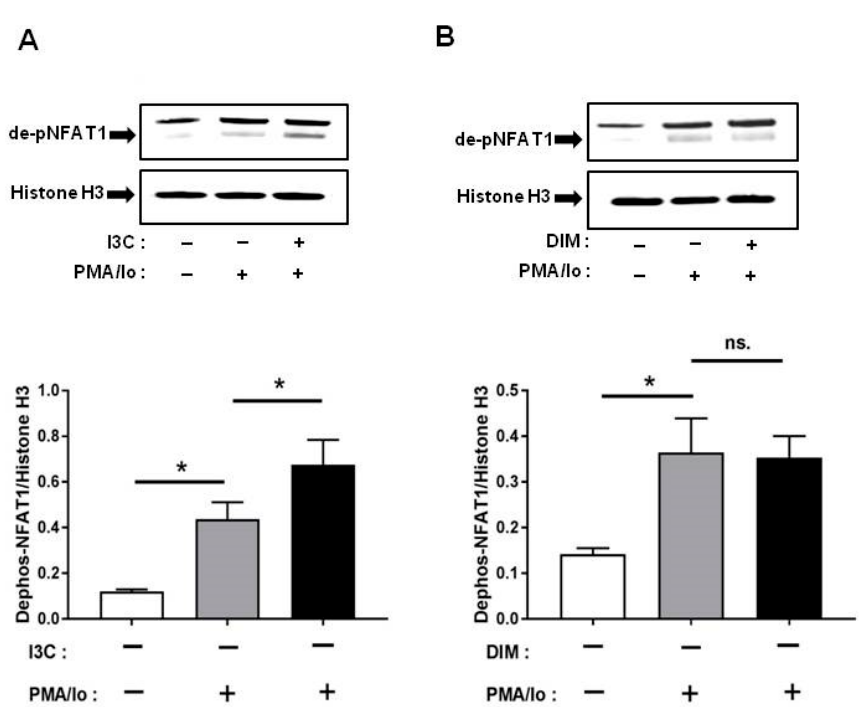
Figure 5. Effects of I3C, DIM on nuclear factor of activated T-cells 1 (NFAT1) dephosphorylation in Jurkat cells. Jurkat cells were treated with 50 µ M of I3C or 10 µ M of DIM for 48 h and then stimulated with PMA+ionomycin for 10 or 30 min. Nuclear extracts were prepared following cell harvest and dephosphorylation of NFAT1 was analyzed by western blot in: ( A ) I3C-pretreated cells; and ( B ) DIM-pretreated cells. Protein expression was normalized to levels of housekeeping gene (Histone H3). The inset shows representative Western blots. Results expressed as mean ± SD ( n = 3). * indicate significantly different from control at p < 0.05 (One-Way Anova and unpaired T -test); and ns., represents not significant.